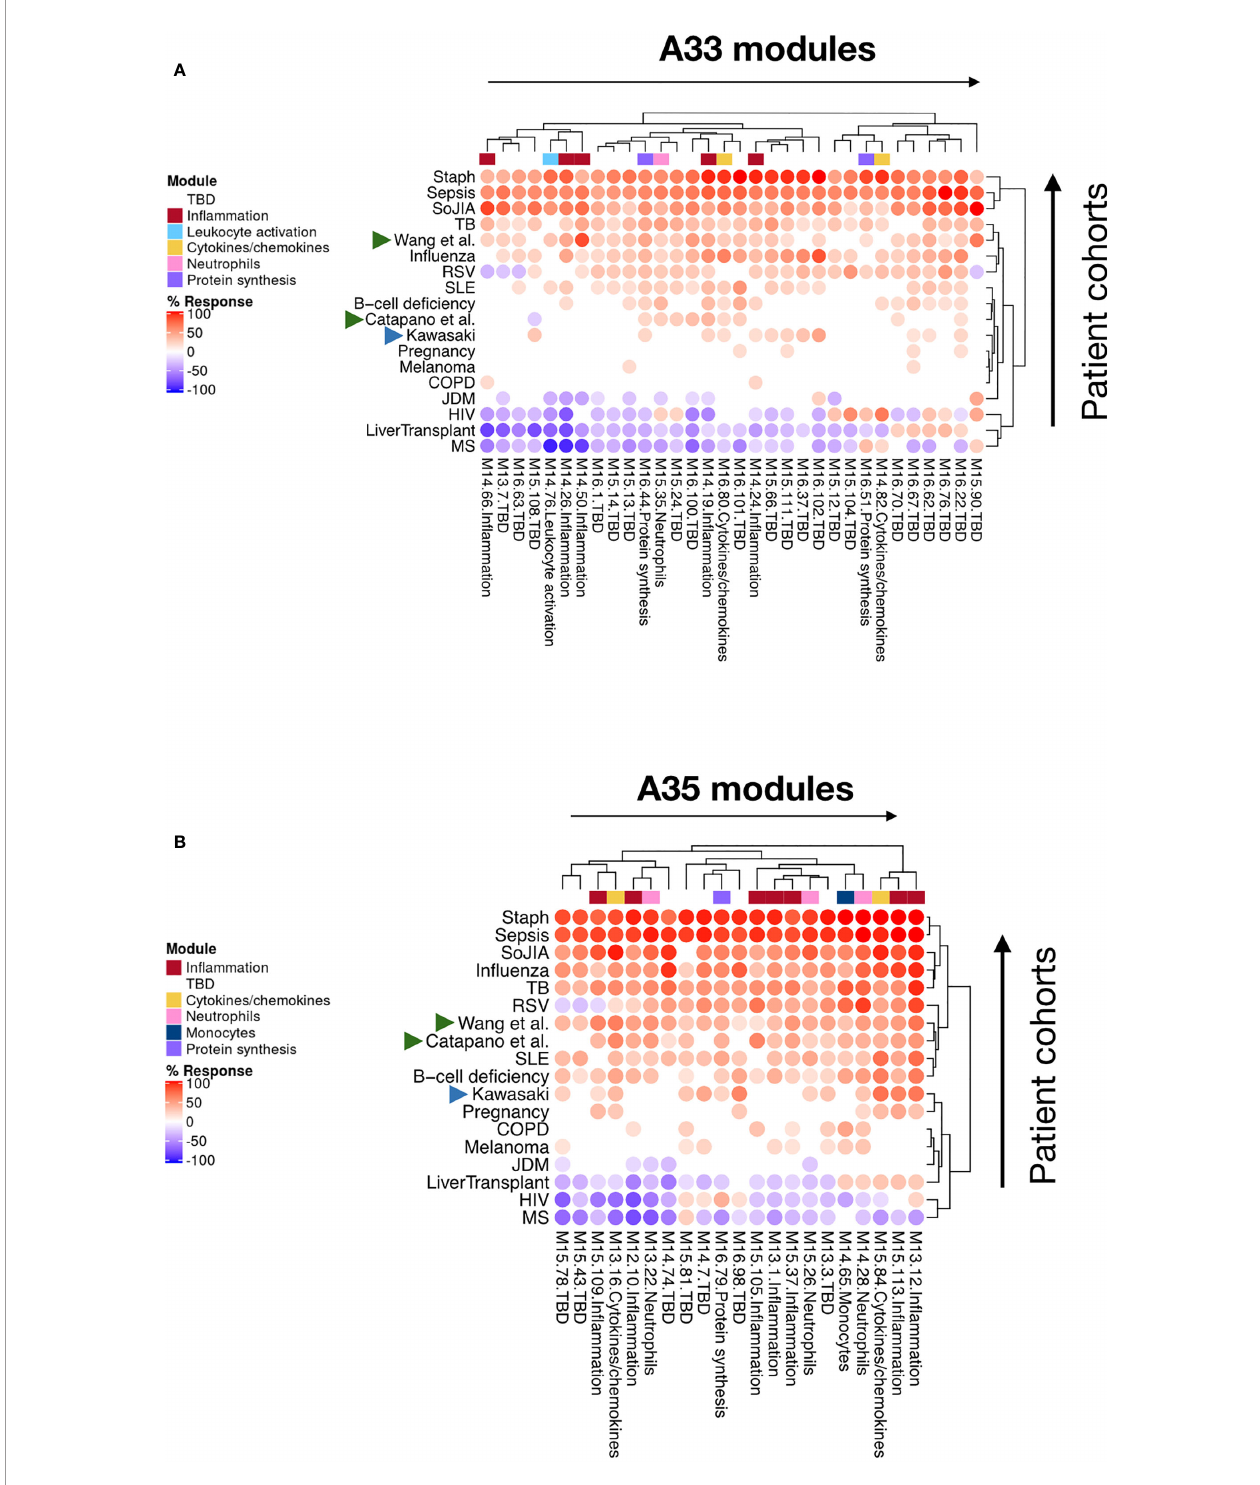
FIGURE 5 | Patterns of abundance for modules forming aggregates A33 (A) and A35 (B) . Heatmaps displaying the changes in transcript abundance for modules (columns) belonging to two aggregates associated with in fl ammation (A33 and A35), across 16 reference datasets and two psoriasis datasets (rows). The two psoriasis datasets are designated by the names of the researchers who contributed them and are indicated by green arrowheads. An increase or decrease in the abundance of transcripts constituting these modules is shown by a red or blue spot, respectively. The rows (datasets from each disease cohort) and columns (modules) were arranged by hierarchical clustering based on similarities in patterns of transcript